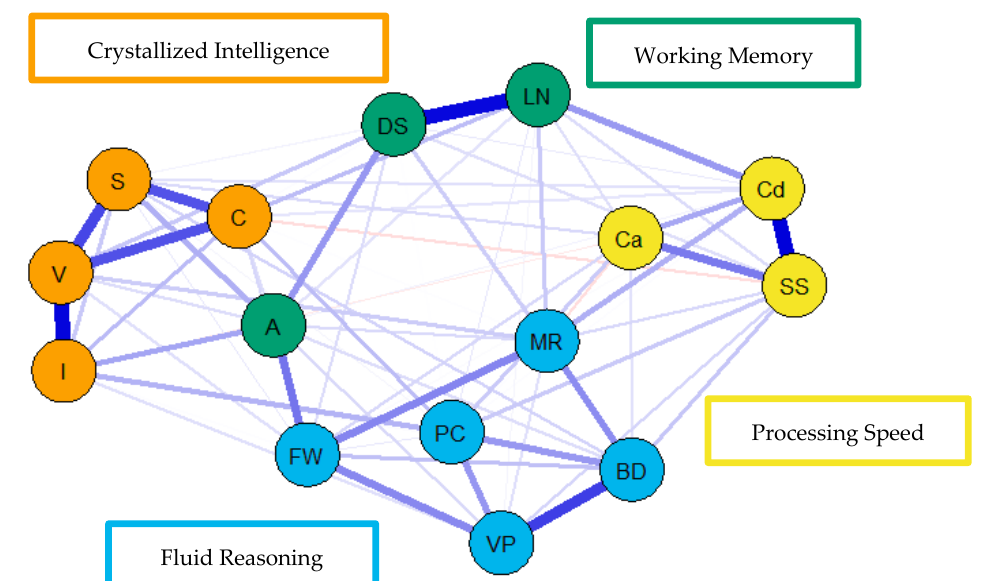
Figure 5. Weighted, undirected psychometric network model of the middle group WAIS-IV correla- tion matrix. BD = block design; S = similarities; DS = digit span; MR = matrix reasoning; V = vocabulary; A = arithmetic; SS = symbol search; VP = visual puzzles; I = information; Cd = coding; LN = letter– number sequencing; FW = figure weights; C = comparisons; Ca = cancellation; PC = picture completion.